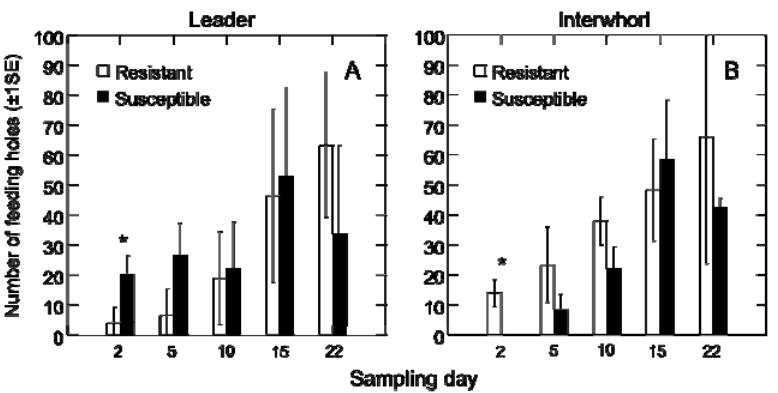
Figure 3. The number of feeding holes on the leader and interwhorl of the resistant and susceptible tree genotypes. (A) The number of feeding holes observed on resistant and susceptible trees (± 1SE) on the leader; and (B) on the interwhorl directly below the leader. An asterisk indicates a significant difference between genotypes (p < 0.05).